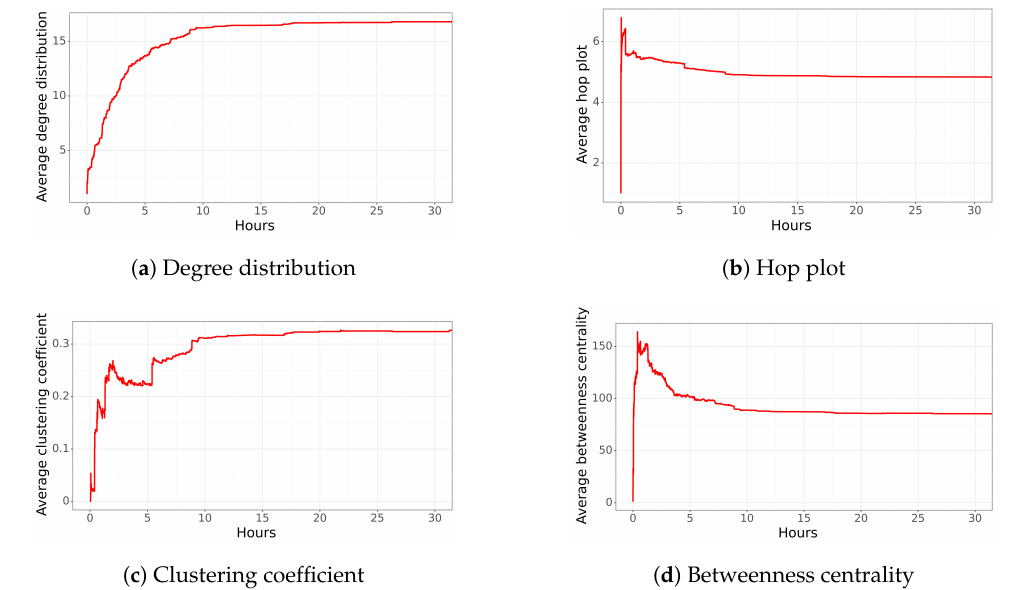
Figure 5. Average network characteristics for the funa to the former military over time. The x-axes of these plots are reduced from 1 week to 30 h to improve